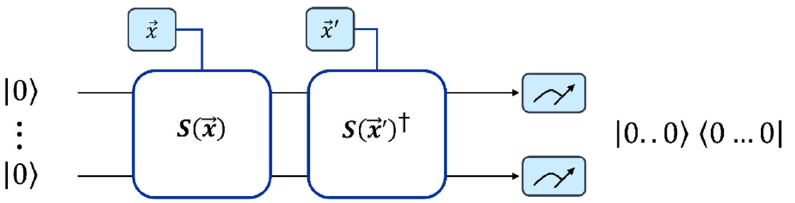
Figure 3. Kernel circuit composed of two encoding blocks applied over the necessary qubits in the basal state. The second encoding block is defined as the complex conjugate of the first one.